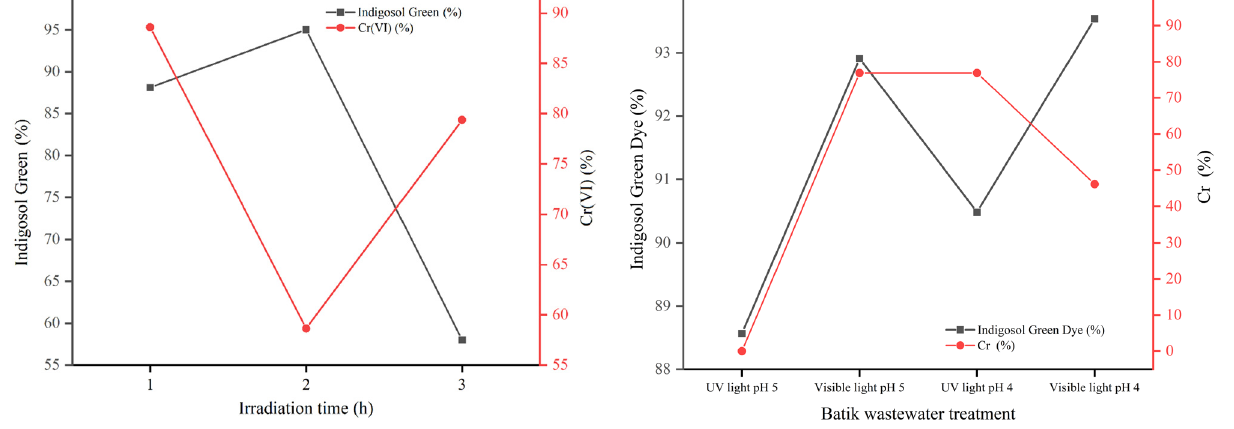
Figure 7: E ff ect of irradiation time for the removal of indigisol green and Cr ( VI ) from aqueous solutions.